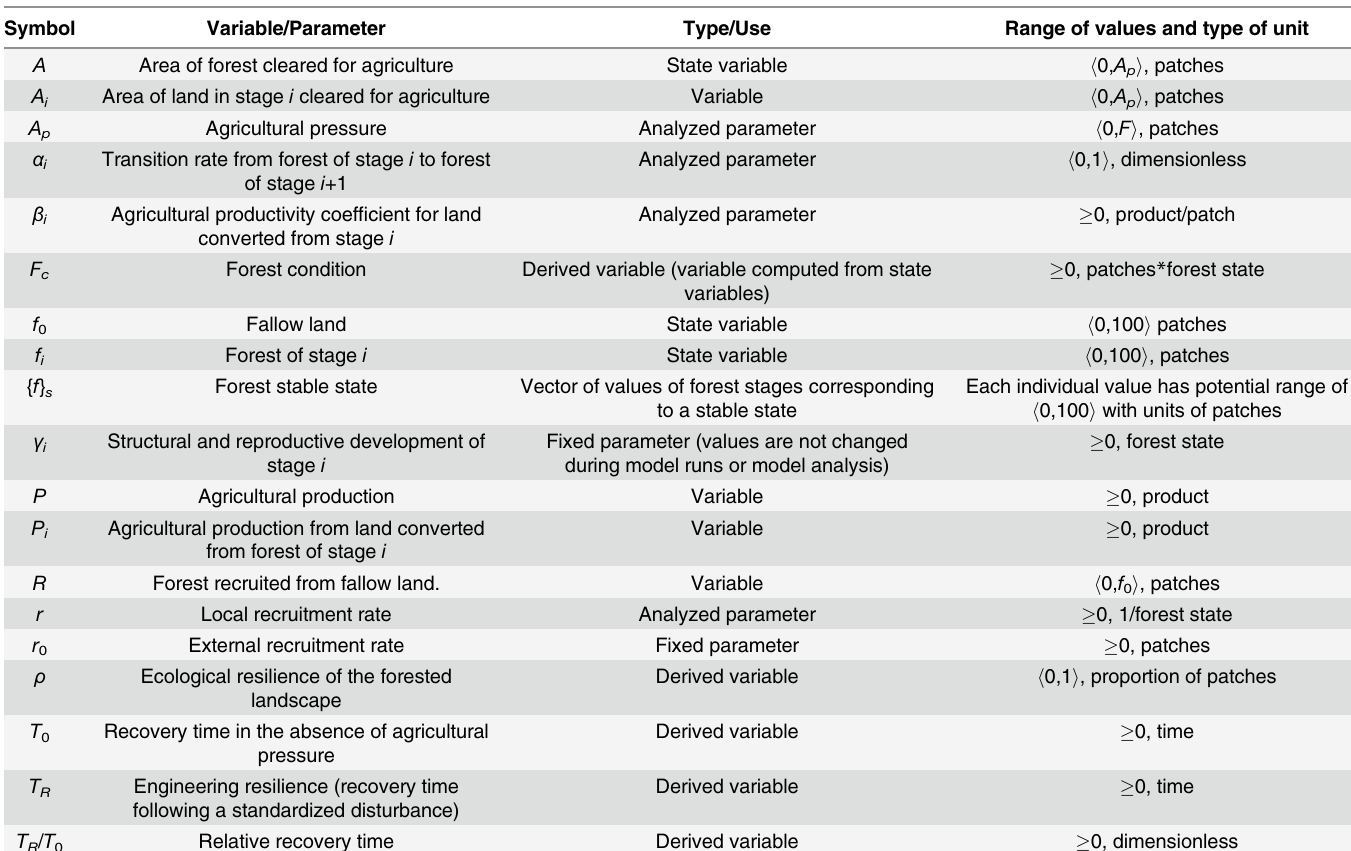
Table 1. Brief explanations of symbols used for variables and parameters in this